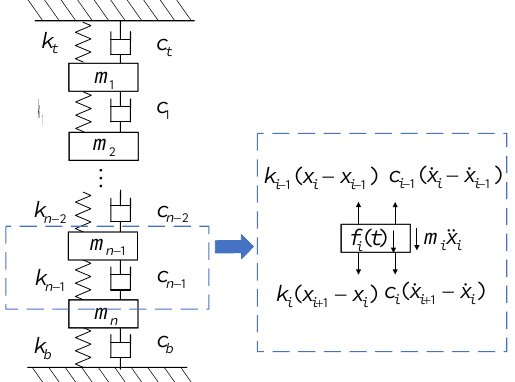
Figure 1. Winding axial mass-damping-spring model.